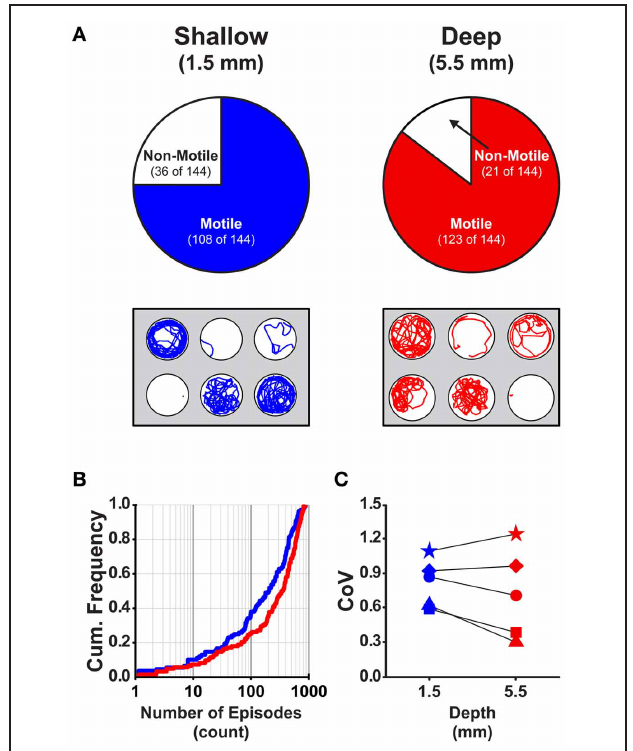
FIGURE 2 | The proportionof motile larvae and the variability among the locomotor properties are different for larvae in shallow and deep behavioral wells. (A) Top Row , Pie charts depicting the proportions of motile and non-motile larvae in Shallow and Deep wells (blue and red, respectively). Bottom Row , Representative trajectory plots for larvae in 6-well behavioral arena plates (30mm well diameter shown); single larva per well. (B) Cumulative frequency plots for the number of swim episodes produced by larvae in Shallow and Deep wells (blue and red, respectively). (C) Plots of the group coefficients of variation (CoV) for all measured locomotor properties in Shallow ( n = 108) and Deep ( n = 123) wells (blue and red, respectively). Symbols are: circle, episode frequency; square, episode duration; triangle, swim speed; diamond, active swim time; star, total